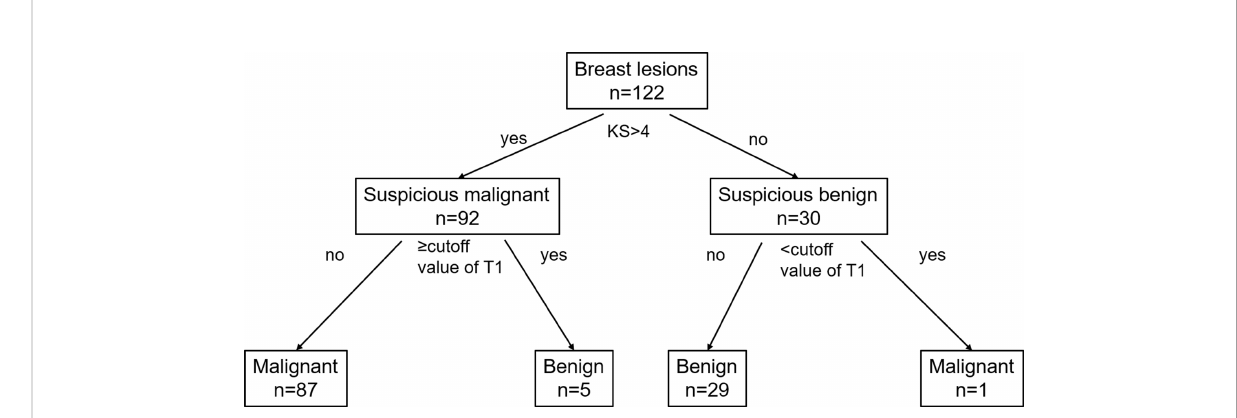
FIGURE 3 Flowchart for the combination of the KS and SyMRI in the differential diagnosis of breast lesions. KS , Kaiser score; T1 , longitudinal relaxation time.